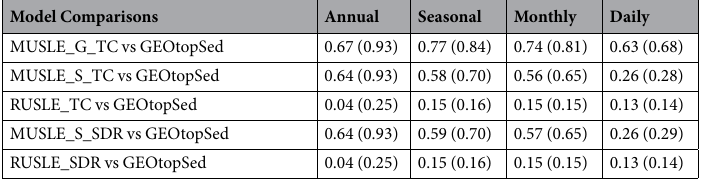
Table 2. Fisher unbiased estimator for simulated SSY at different temporal scales. Values in the parenthesis are Fisher estimator after discarding data from